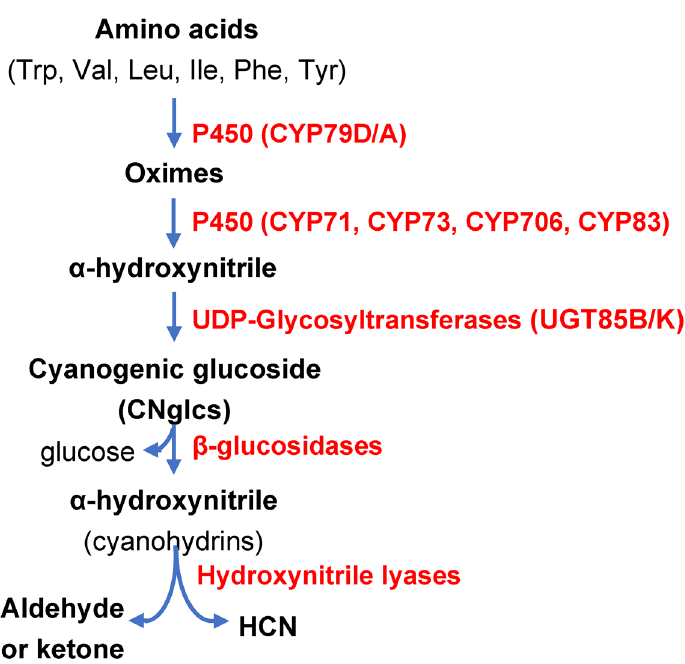
Figure 2. Scheme of biosynthesis and catabolism of Cyanogenic Glucosides (CNglcs). Enzymes are indicated in red colour.